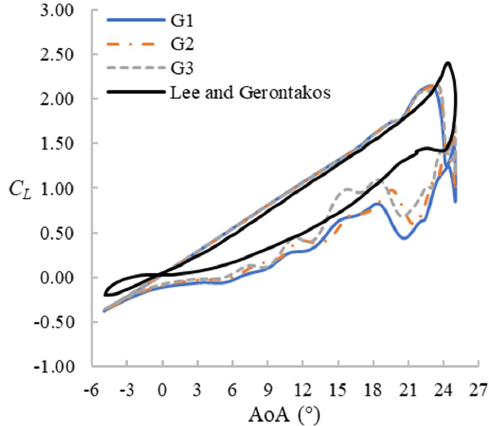
Figure 3. Lift and drag coefficient for different mesh resolutions (2D, Δt = 0.001s). Static stall.